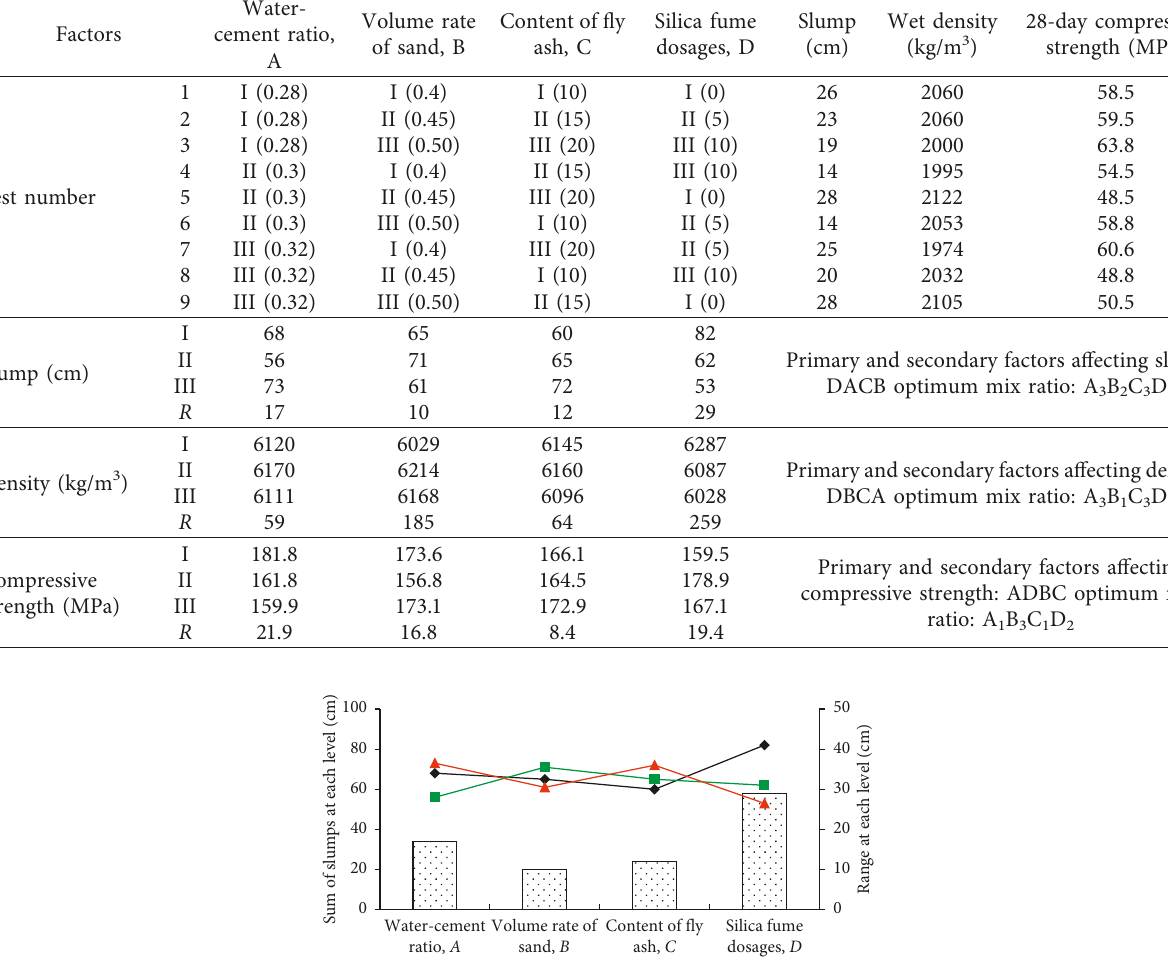
Table 3: Analysis of orthogonal experimental results.